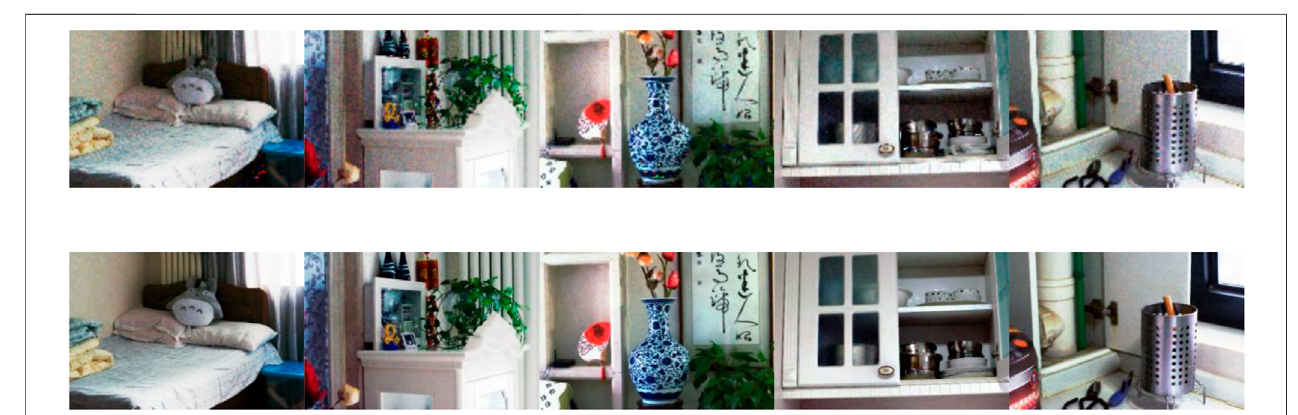
FIGURE 3 | The fi rst row is the image obtained after FGIF processing; The second row is the image obtained after WGIF